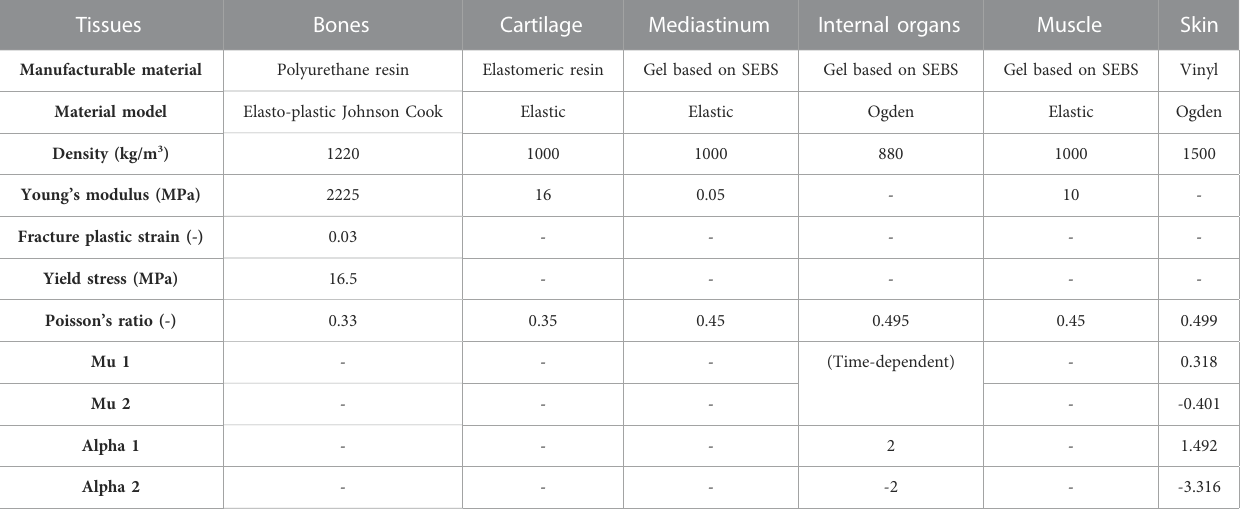
TABLE 2 Material parameters used in SurHUByx FEM.